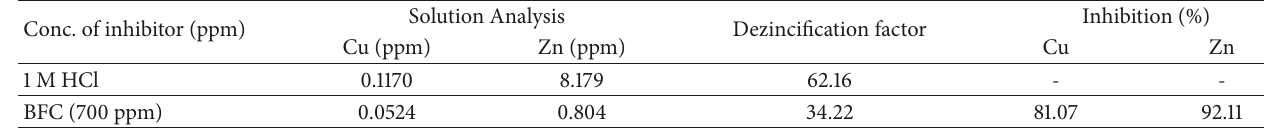
Table 4: Solution analysis by AAS for brass in 1M HCl with BFC.